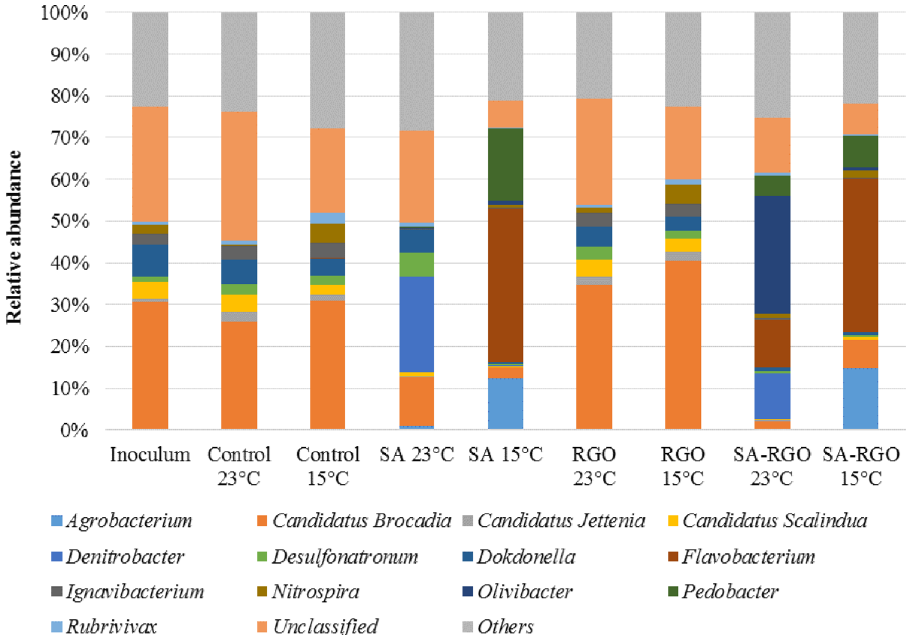
Figure 7. Microbial community composition at genus level in the inoculum and investigated SBRs at 23 °C and 15 °C: control reactor, a reactor with RGO addition, a reactor with biomass immobilized in SA, and a reactor with biomass immobilized in